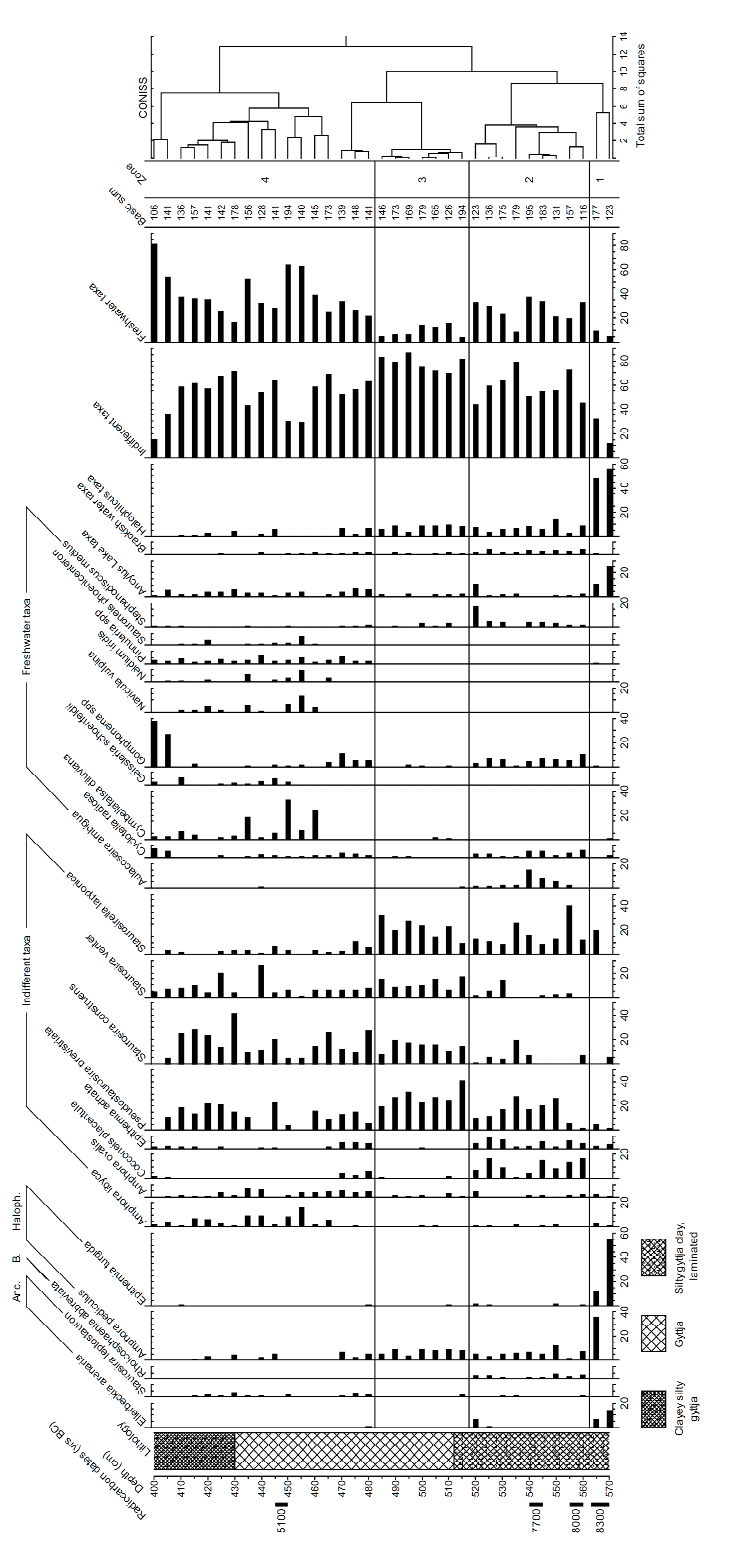
Figure 3. Diatom data from Lake Boren.